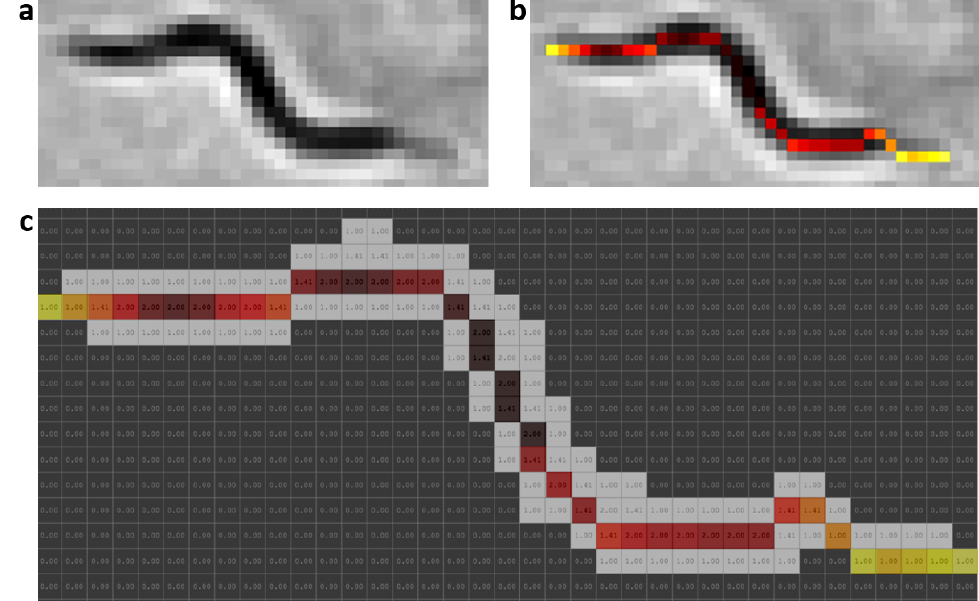
Figure 2. Prediction model. Skeleton gray values were changed with a HOT color map for better visualization. ( a ) Grayscale image. ( b ) Color values obtained from grayscale image. ( c ) Values of widths marked with the colors of the model; the length is the total pixels in the